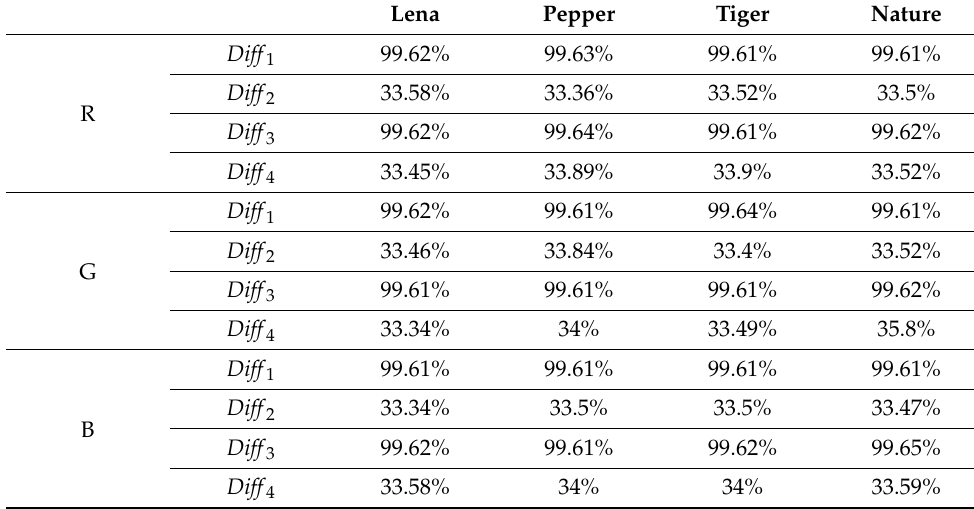
Table 5. The computed key sensitivity